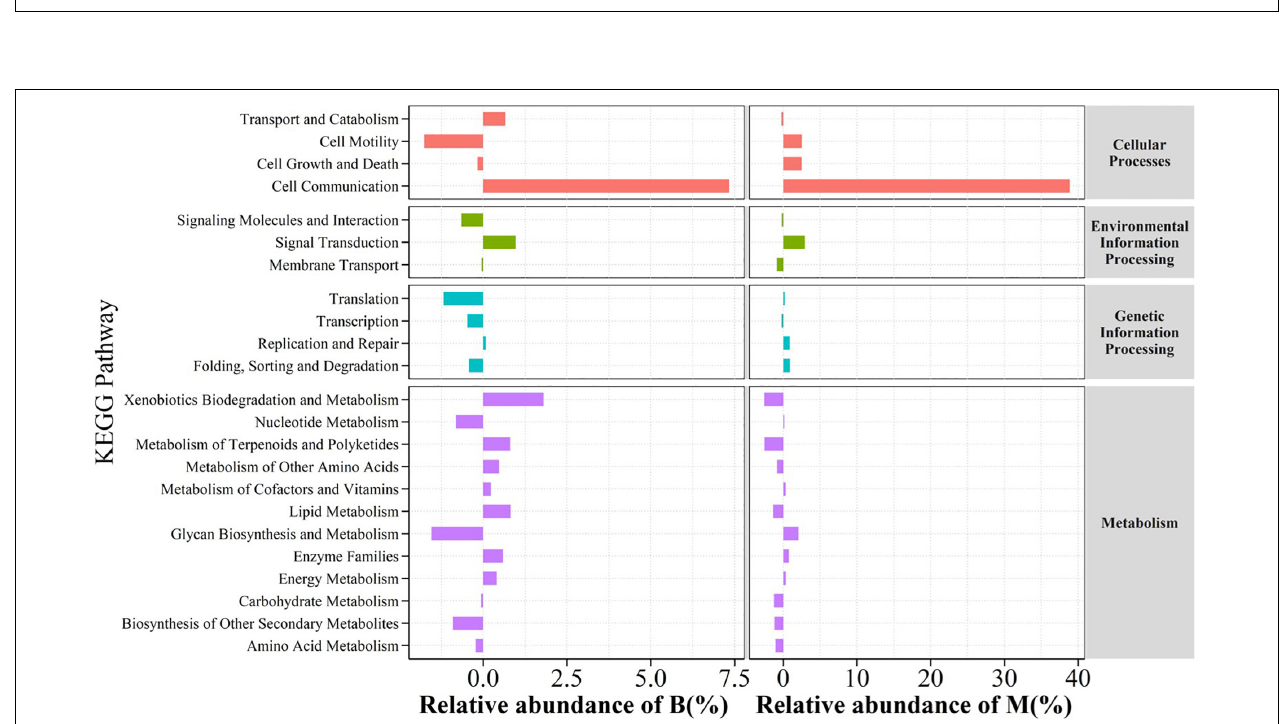
FIGURE 8 | Functional genes analysis of relative abundance changes on Bottom compared to Top and relative abundance changes on Middle compared to Top of the slope.